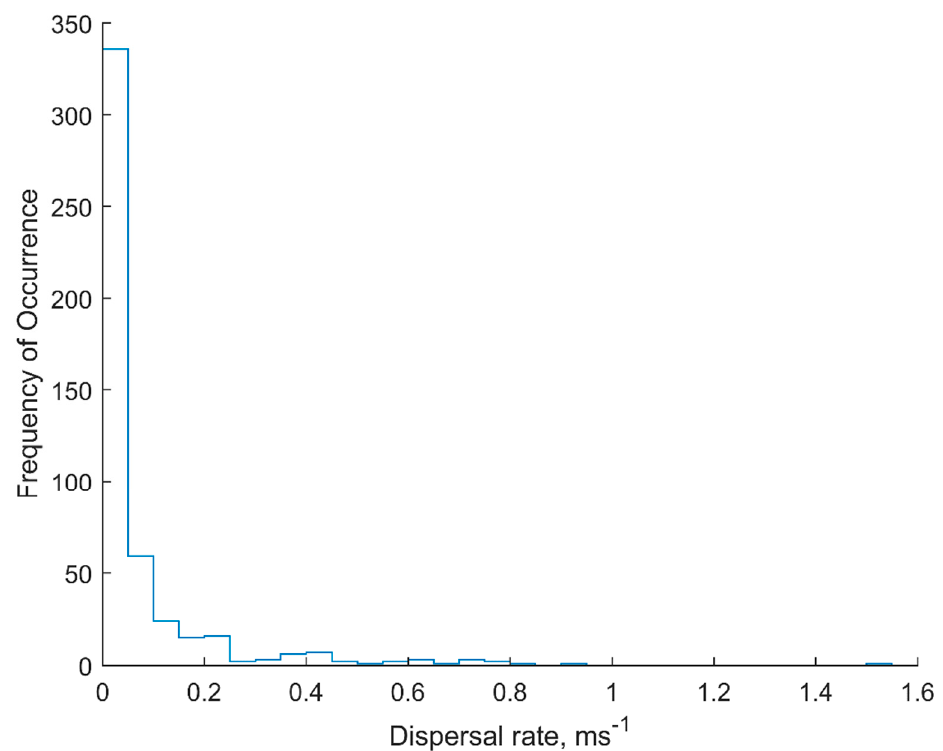
Figure 7. Histogram of the distribution of dispersal rate plus error ( γ ) of acoustically tagged juvenile Chinook salmon in marine waters of Port Walter and Big Port Walter, Alaska.